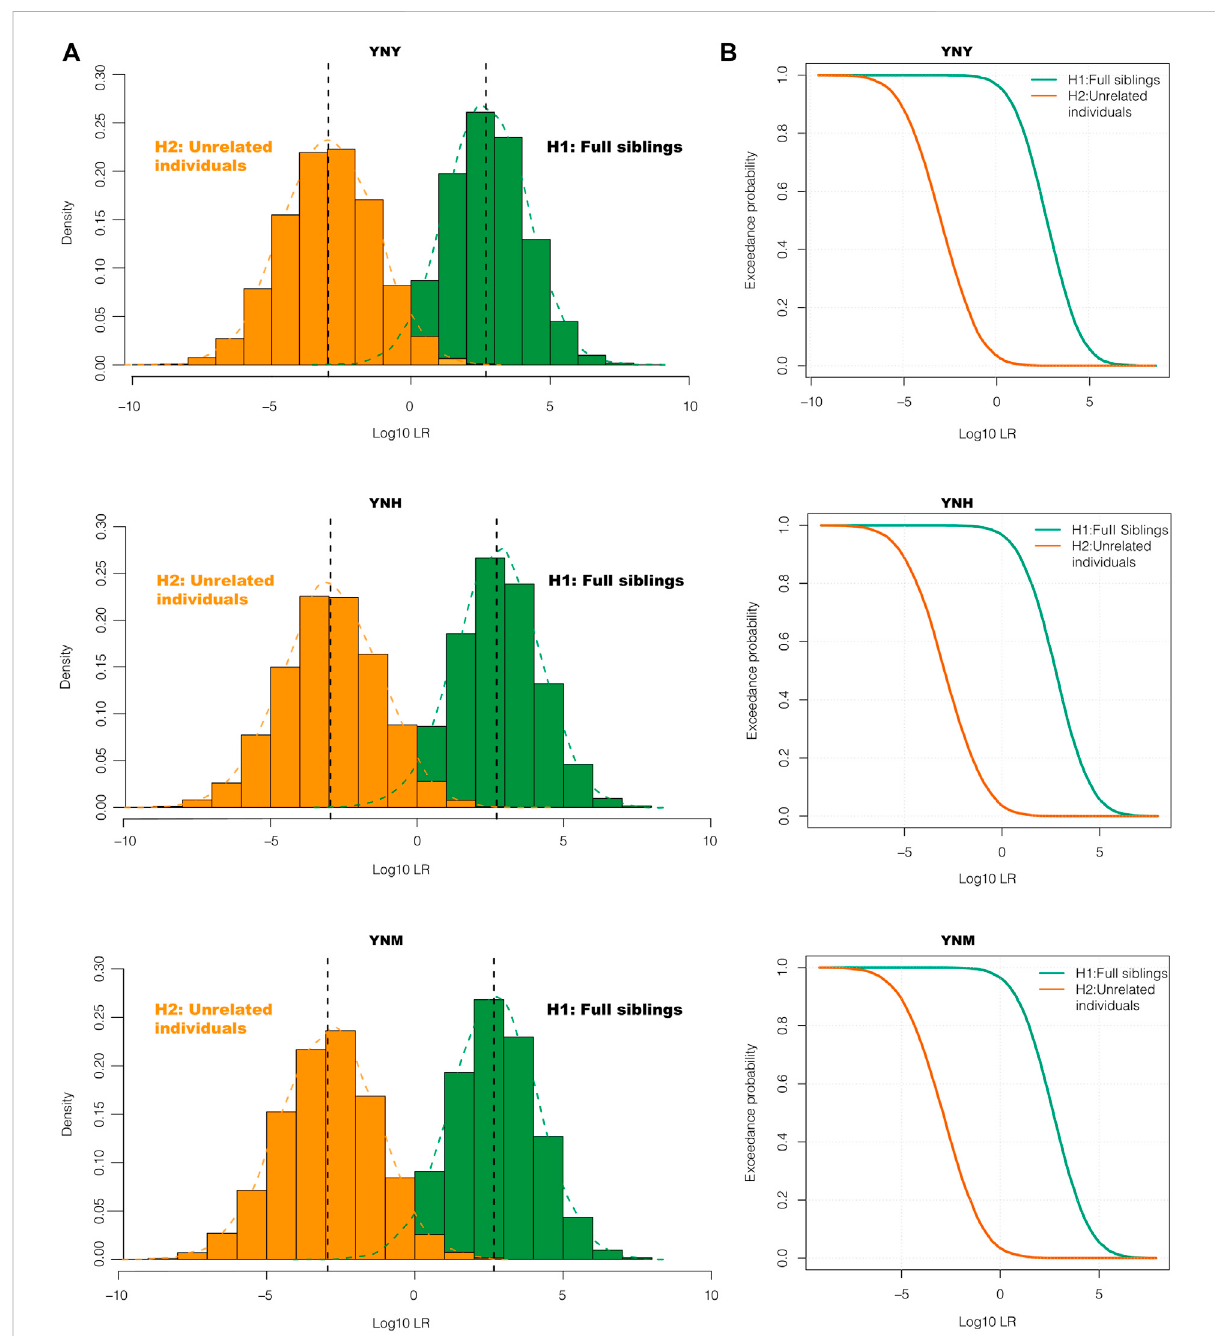
FIGURE 2 The probability density curves (A) and log 10 LR density distribution curves (B) of full-sibling pairs and unrelated individual pairs with the 43 A-DIPs. The LR values of prosecutive hypothesis H1 and defense hypothesis H2 for Yunnan Yi (YNY), Yunnan Hani (YNH) and Yunnan Miao (YNM) groups were shown from the top to the